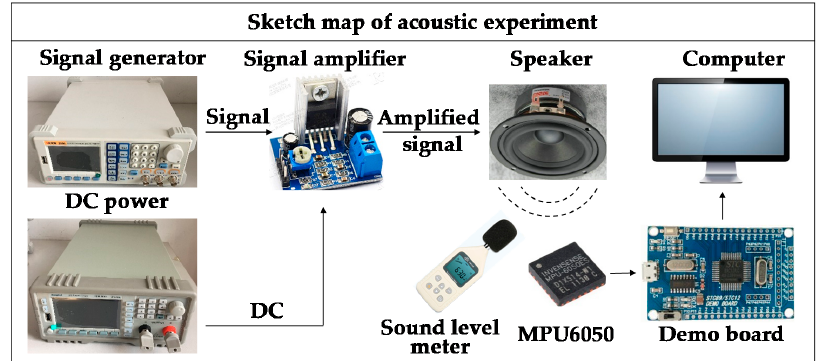
Figure 2. Overview of the sound injection experiment.